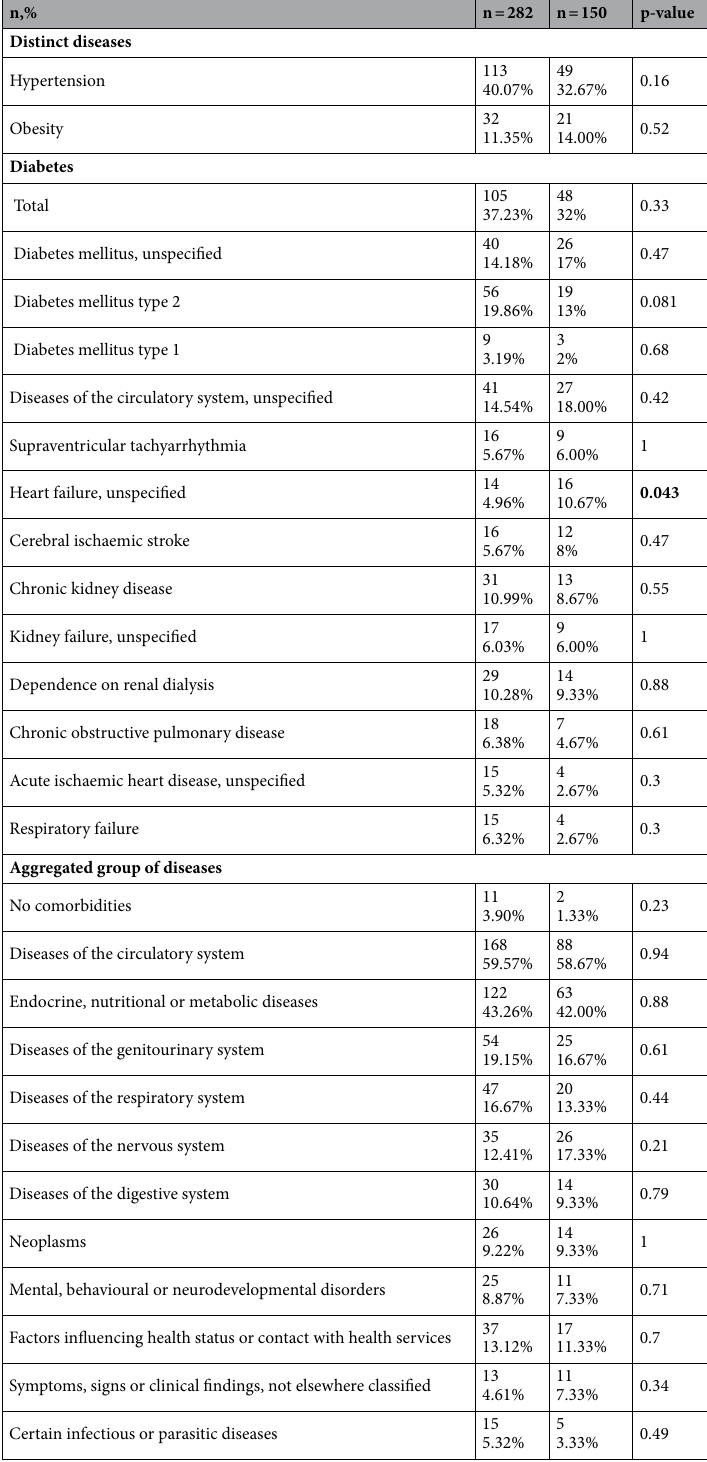
Table 1. Association between gender and distinct diseases or aggregated group of diseases, as absolute numbers and as percentage. In bold the differences that reached the statistical